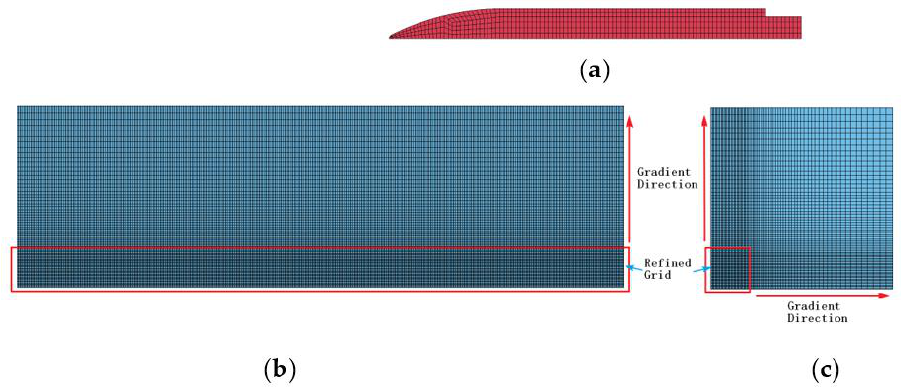
Figure 6. Establishment of 3D model: ( a ) projectile model; ( b ) sectional view of target 1/4 model; ( c ) target impact surface 1/4 model.